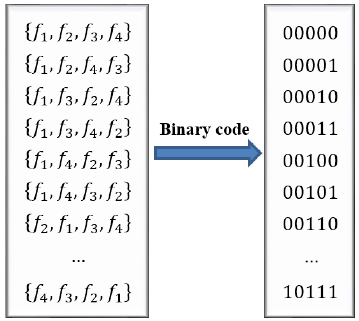
Figure 1. Mapping of different orderings to binary codes according to CSC. The ideal case for key generation is to put all the PUF measurements in the same